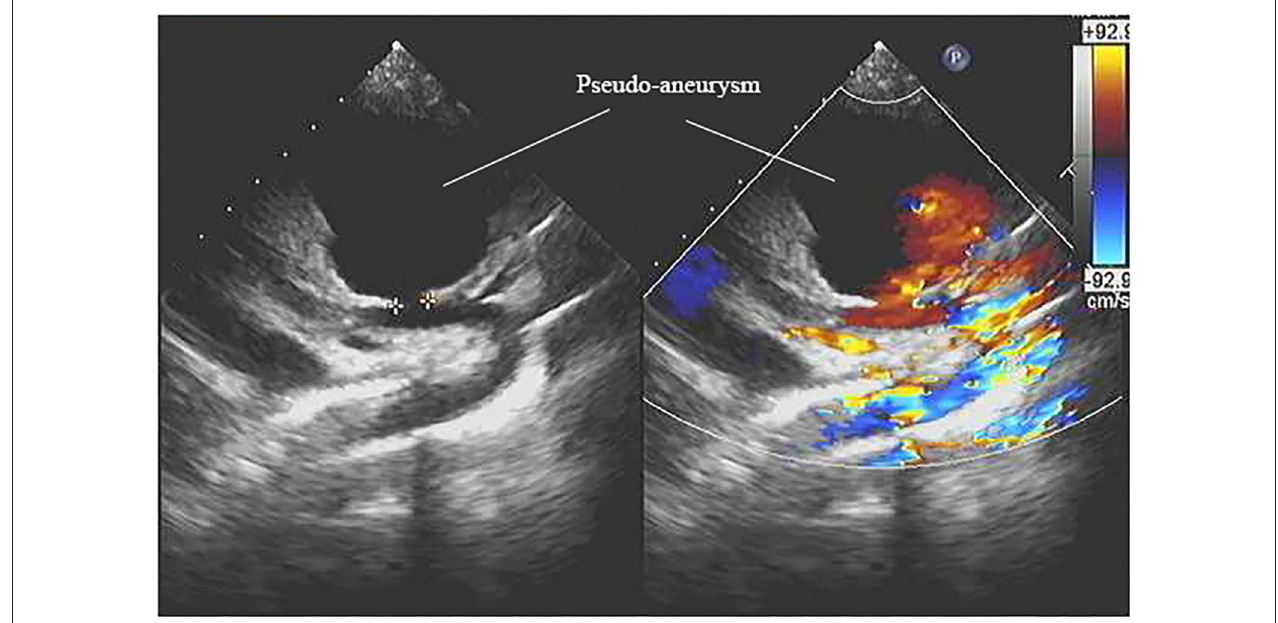
FIGURE 1 | An echocardiography view represents the aortic pseudo-aneurysm.